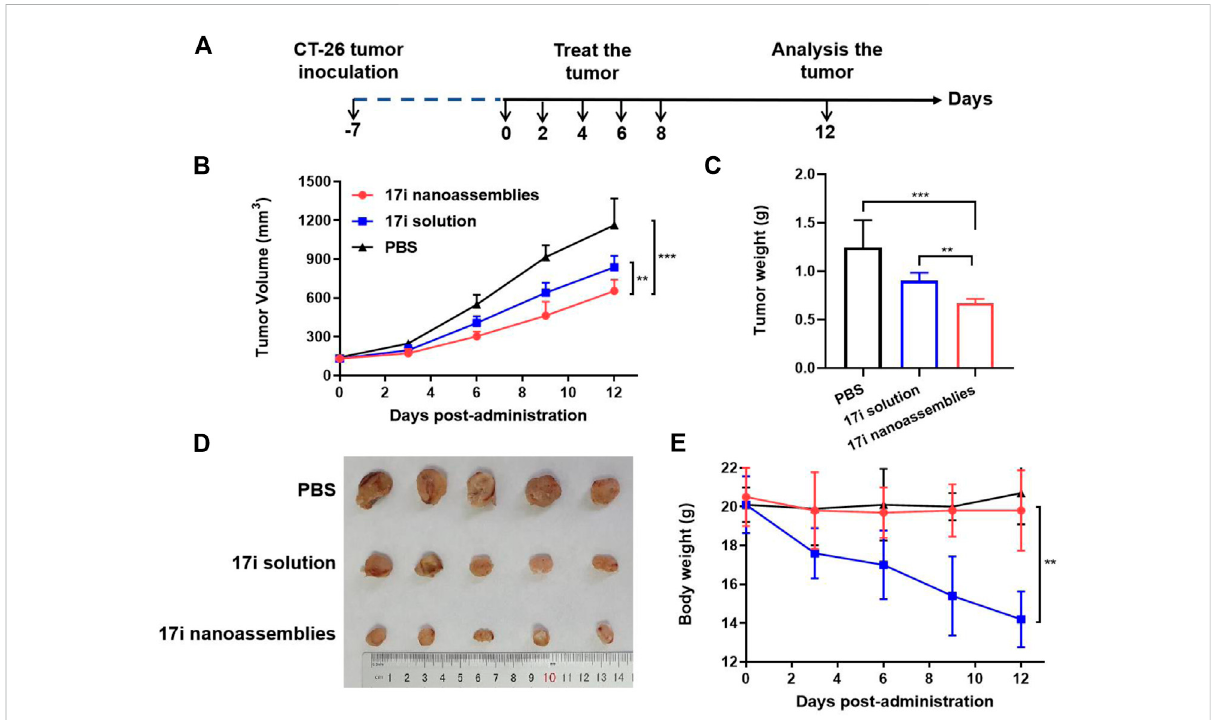
FIGURE 6 In vivo anti-tumor ef fi cacy of 17i solution and PEGylated 17i nanoassemblies against CT-26 tumors. (A) Therapeutic protocol on mouse CT26 subcutaneous tumor xenograft. (B) Tumor volume growth curve after different treatments. (C) Tumor weight (G) of mice after 12 days in different treatments (n = 5). (D) After repeated administration, excised tumors of different groups are shown. (E) Changes in body weight of mice during different treatments (n =